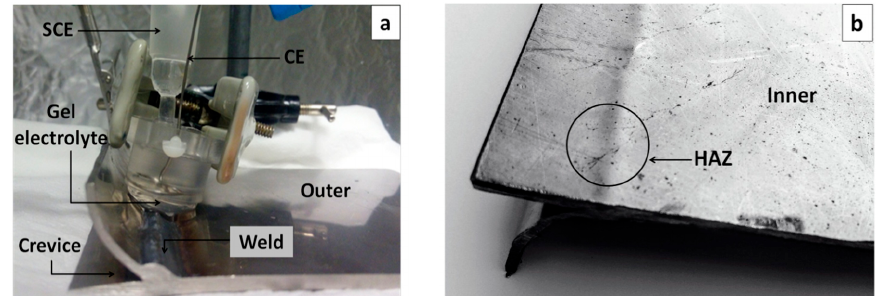
Figure 1. Welded part from a stainless-steel tank studied with the portable gel cell: ( a ) portable gel cell and outer surface of the tank; ( b ) inner surface of the tank, where small cracks and pits had appeared during its in-service